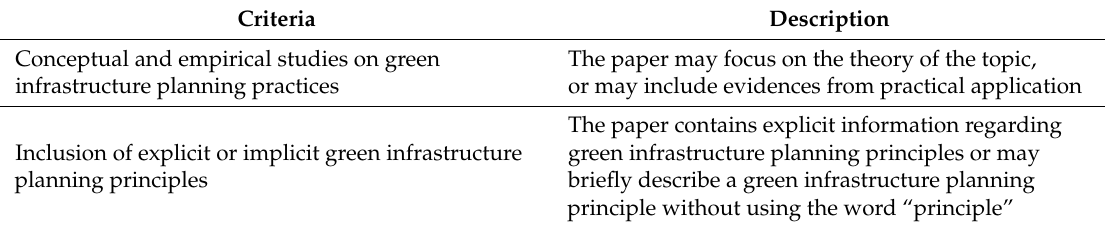
Table 1. Inclusion and exclusion criteria used in the screening